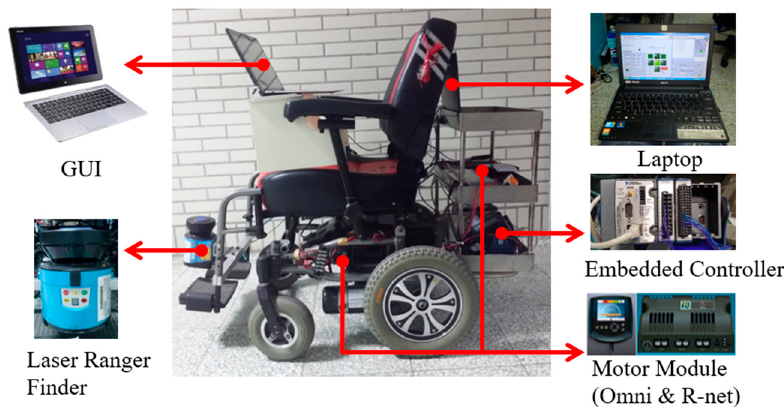
Figure 1. The utilized hardware components for i E-Wheelchair.